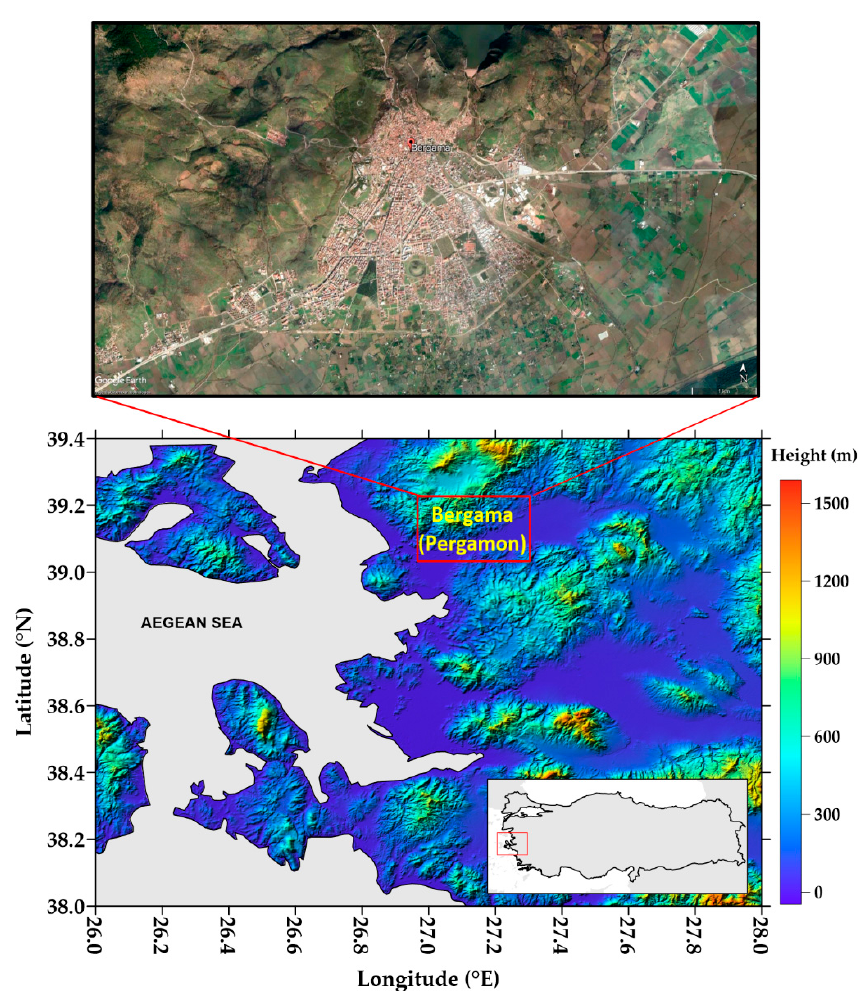
Figure 1. Test site location and topography using ( top ) Google Earth image and ( bottom ) SRTM DTM.